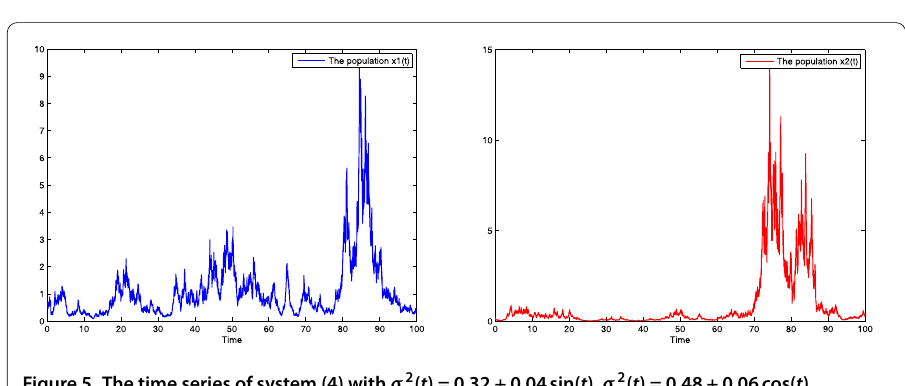
Figure 5 The time series of system (4) with σ 2